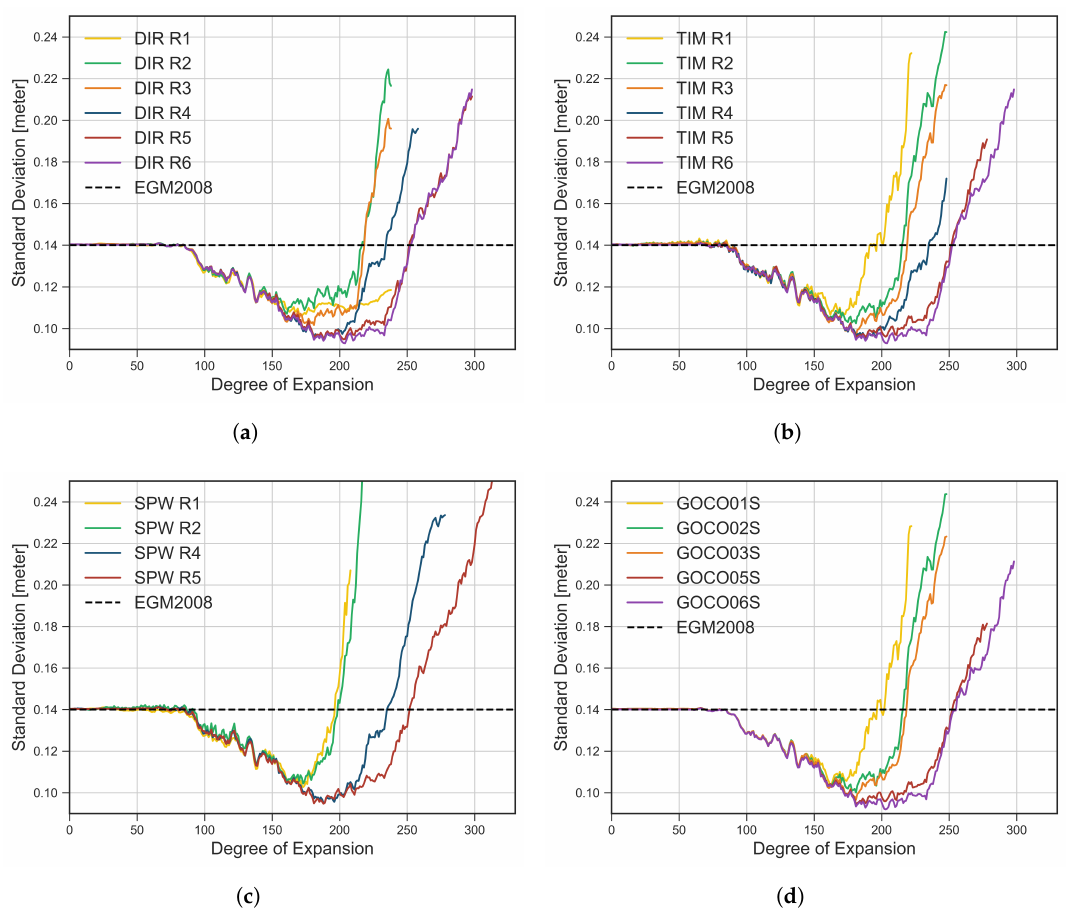
Figure 5. Standard deviations of the residual geoid heights of the spectrally enhanced GOCE models at each expansion degree: ( a ) DIR models, ( b ) TIM models, ( c ) SPW models, and ( d ) GOCO